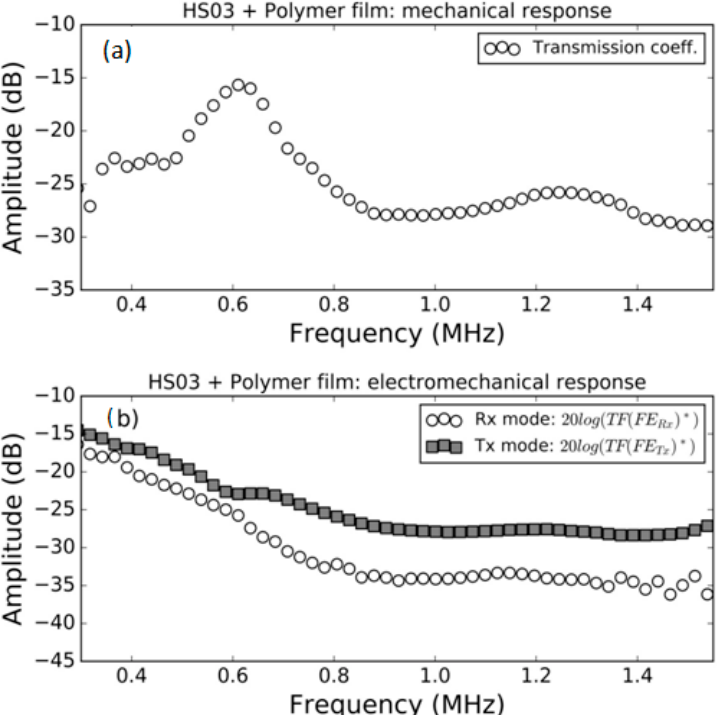
Figure 9. Measured response of the HS03 FE + adhesive film sample in water. ( a ) Modulus of the transmission coefficient vs. frequency; ( b ) electromechanical response vs. frequency both in Tx and Rx mode, (see Equations (16) and